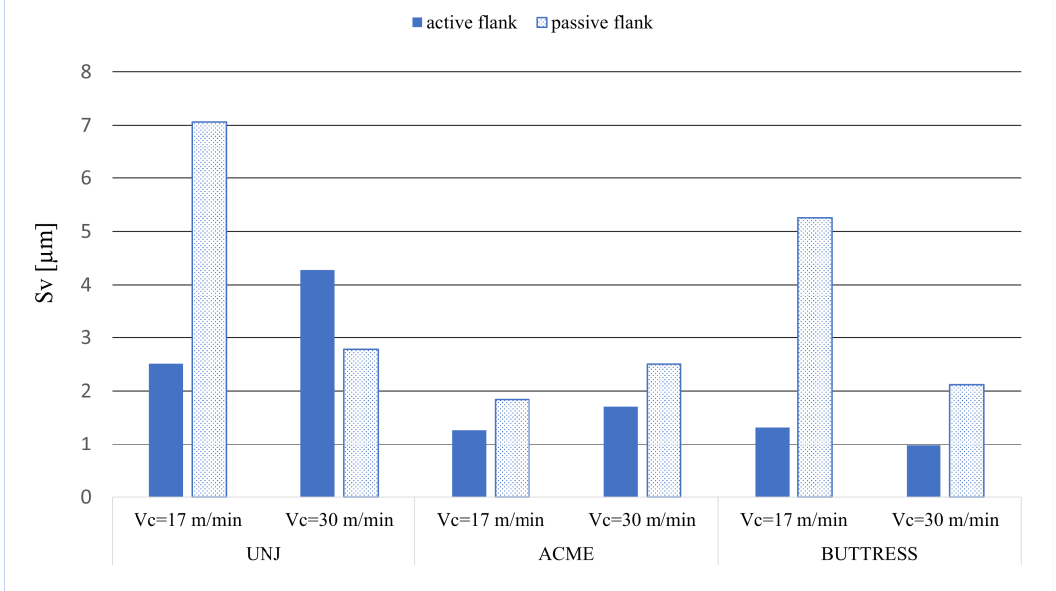
Figure 8. Sv values for the measured surfaces.